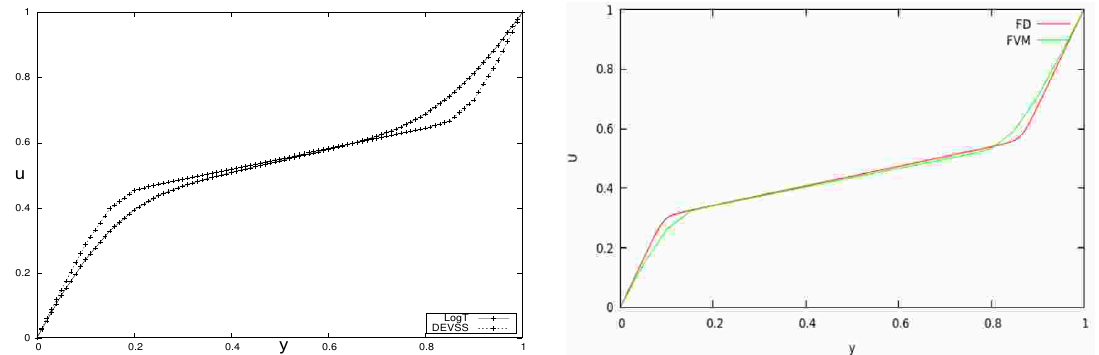
Figure 2. Velocity profile ( u ) for We = 2, η S = 0.05, η P = 0.95, ξ = 0.8, and Re = 1 for the Johnson–Segalman model (compared with reference [24] (RHS)).